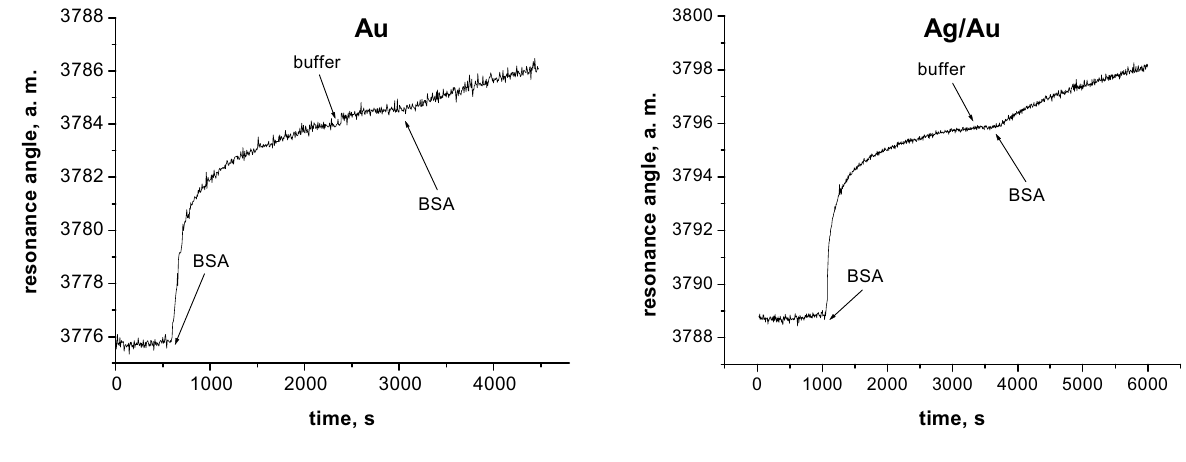
Figure 5. Sensorograms for adsorption of bovine serum albumin onto gold (left) or bimetallic (right) silver/gold (thickness 1:1, silver as inner layer) coated by 1-hexadecanthiol. Buffer: 150 mM KCl, 5 mM phosphate, pH 7.0 (right).